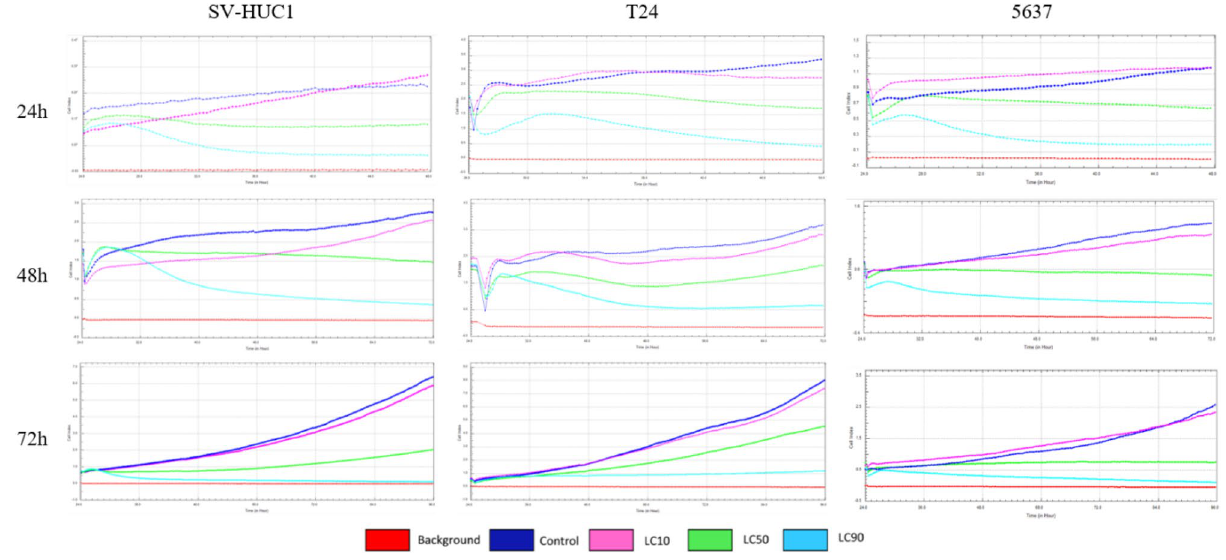
Figure 6. Real-time cell analysis after exposure to the calculated lethal concentrations of Mumio for 24, 48 and 72 h. Our results confirmed the LCs calculated with MTT for all cell lines for all three incubation times. The charts represent readings in 15 min intervals after the addition of Mumio. SV-HUC-1—normal urothelial cell line, T24—transitional urinary bladder carcinoma cell line, 5637—grade II urinary bladder carcinoma cell line, LC—lethal